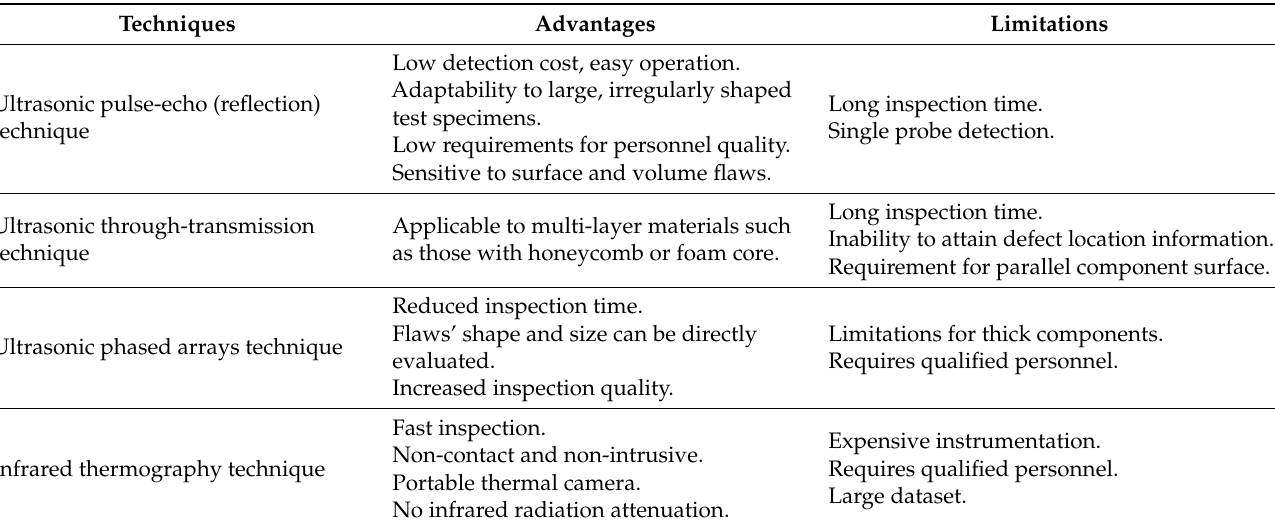
Table 1. Advantages and limitations of existing technologies for aluminum window